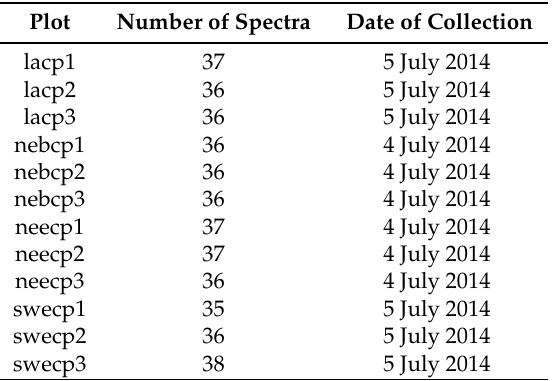
Table 1. Number and date of community spectra collected; no species-level spectra were used for this study. Signatures were collected in a two-day period during peak growing season to minimize seasonal variability and soil signature while providing a fair comparison across plant communities. Plot Number of Spectra